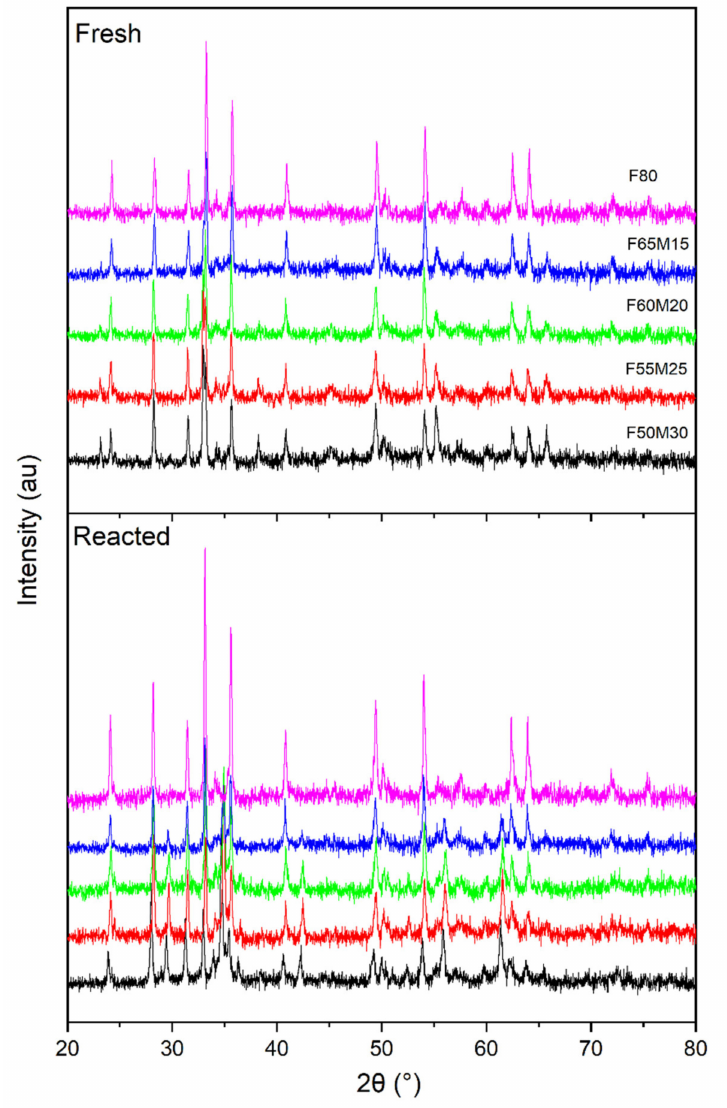
Figure 2. Comparison of X-ray diffraction pattern between fresh and reacted